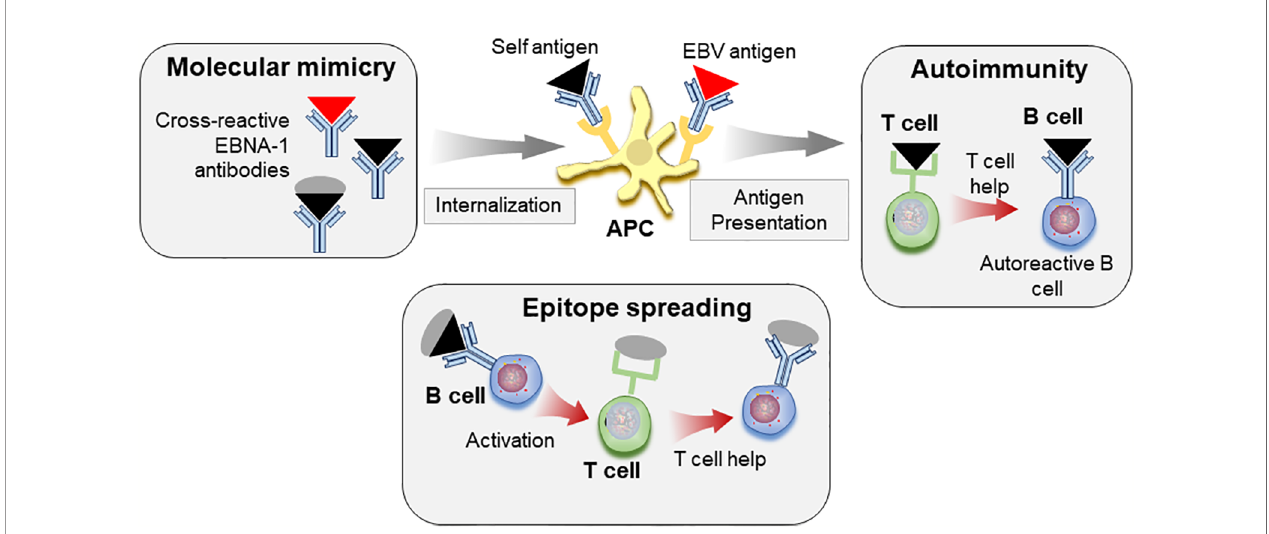
FIGURE 3 | Molecular mimicry and epitope spreading in autoimmunity. Antibodies to viral antigens such as EBNA-1 (red triangle) cross-react with autoantigens (black triangle) due to structural similarities. Immune complexes consisting of autoantigen/antibody complexes are internalized by antigen presenting cells (APC), antigen is processed and peptides presented to T cells, which can allow for loss of tolerance. Defective T cell tolerance possibly contributed by genetic susceptibility may be responsible for this loss of tolerance. These autoreactive T cells in turn provide help to auto-reactive B cells leading to autoreactive antibody response. The self-protein bound to B cell receptor is internalized, processed, and presented to T cells. The autoimmune response can be further diversi fi ed by epitope spreading. B cells speci fi c for viral antigen (red triangle) can recognize similar structures on self-antigen (black triangle). However, these cells can internalize and present peptides from whole protein that carries the cross-reactive epitope (black triangle+gray circle) to T cells, which then provide help for antibody response towards additional epitopes on the protein by B